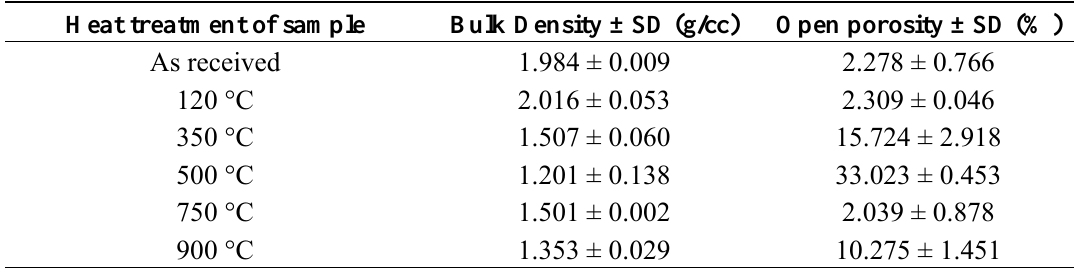
Table 1. Bulk density and open porosity of as-received and heat treated